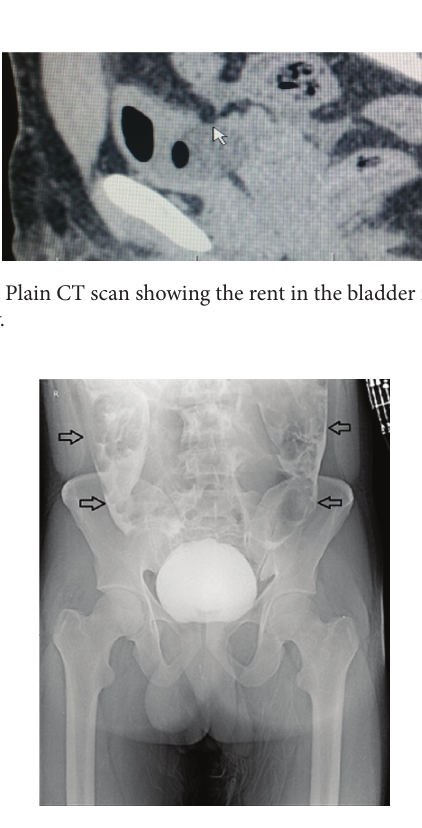
Figure 2: Cystogram showing extravasation of the contrast into the peritoneal cavity marked by arrows.